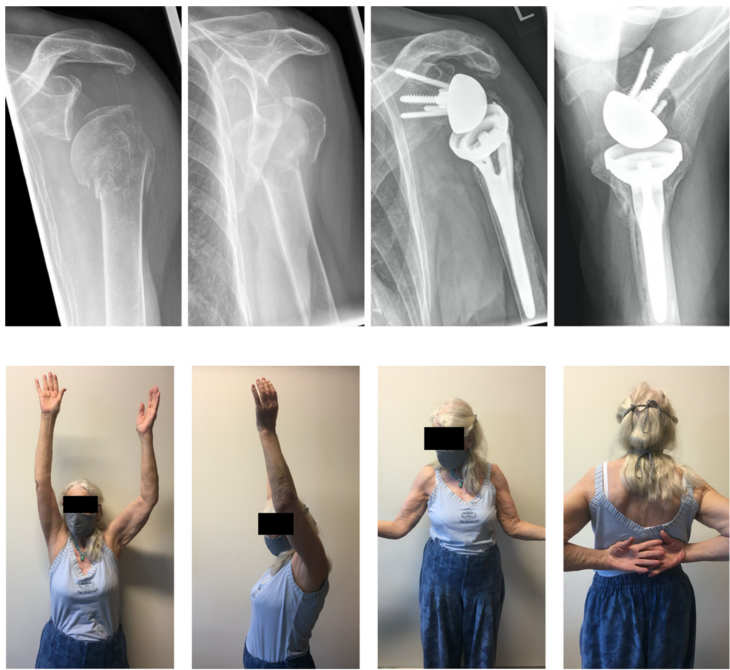
Figure 3. This 77-year-old woman sustained a type III fracture in preoperative radiographs ( upper two left ) after a fall onto her left shoulder while hiking. At 50 months post-RSA, the patient was very satisfied with excellent function ( lower bottom ) and a CS of 81 points, a relative CS of 99%, and a SSV of 95%. Both the greater and lesser tuberosities show healing and no scapular notching is visible on post-op ( upper two right )